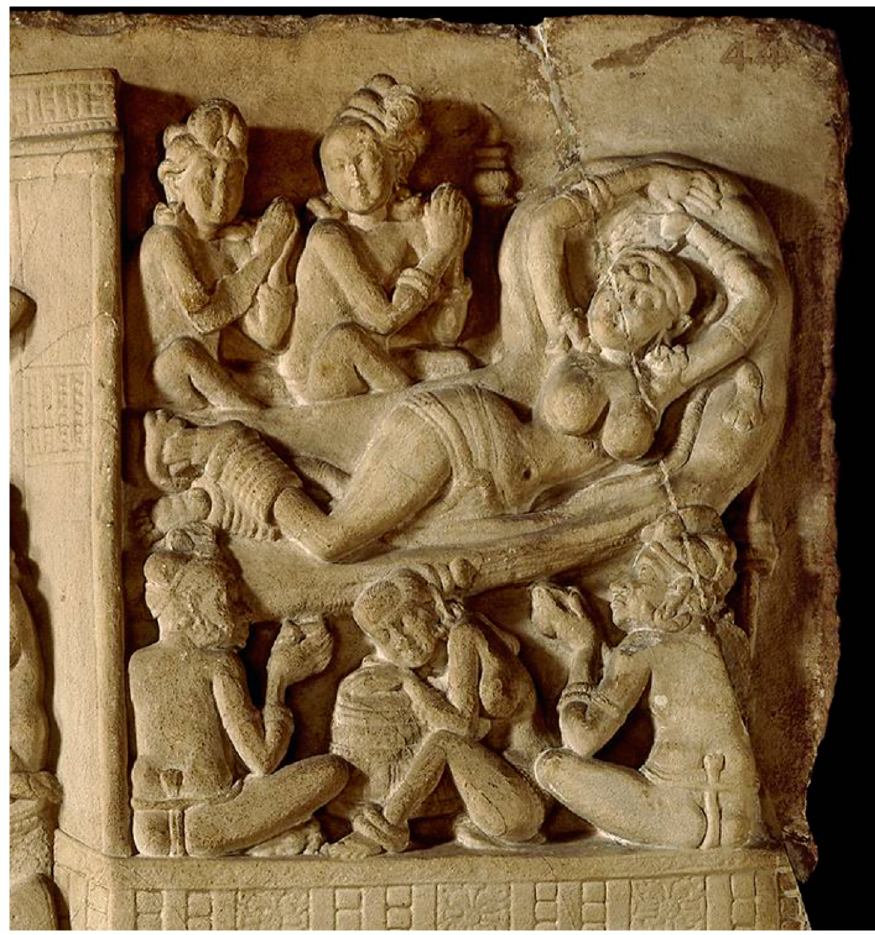
Figure 2. Amaravati, The British Museum, London, no. 44 © The Trustees of the British Museum. All rights reserved.